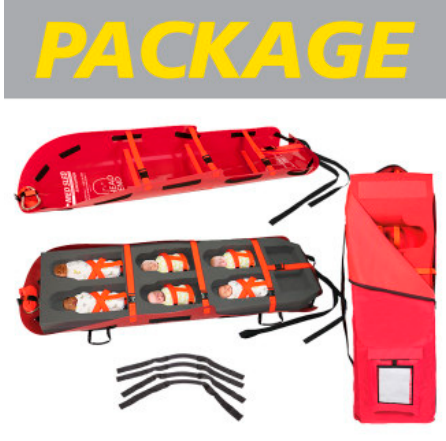
Figure 2. Med Sled ® Infant 6 insert .